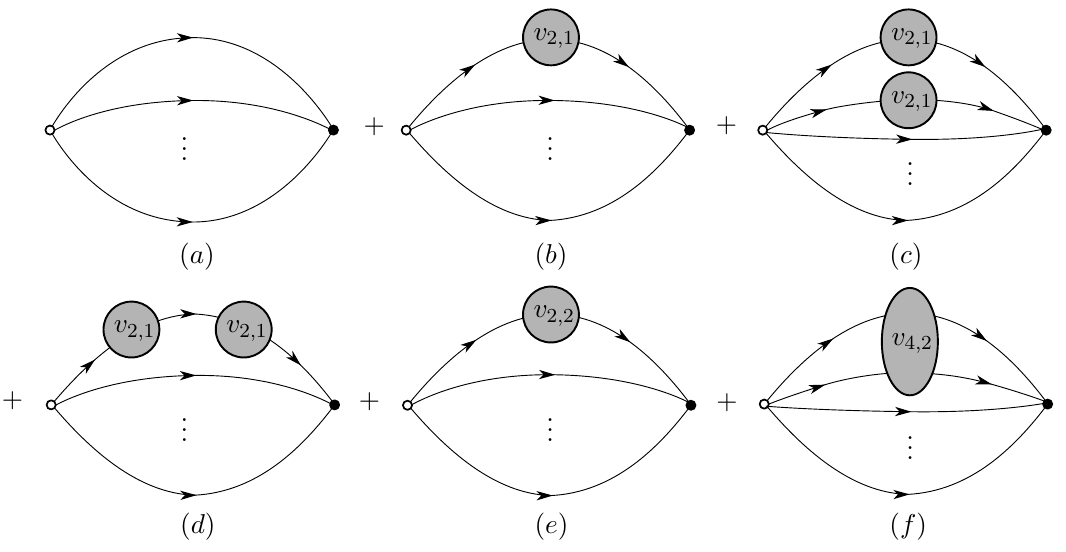
Figure 1 . The Feynman diagrams contributing to the two-point correlators. White and black dots stand for the operators O ~n and (cid:22) O ~m , respectively. Lines with arrows denote free scalar propagators. The e(cid:11)ective vertex v k;‘ represents the sum of irreducible diagrams with k external legs at ‘ loops. is the massless scalar propagator in D -dimensions. The correlator G computed at weak coupling as an expansion in powers of g 2